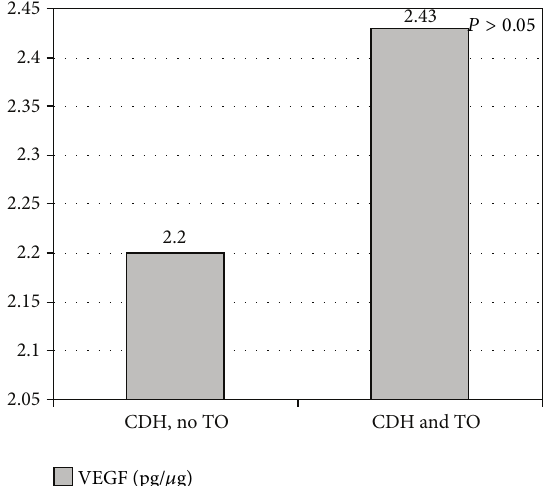
Figure7:Vascularendothelialgrowthfactor(VEGF)infetuseswith congenital diaphragmatic hernia (CDH). Comparison of tracheal occlusion (TO) versus no TO. Values are expressed as mean (pg/ 𝜇